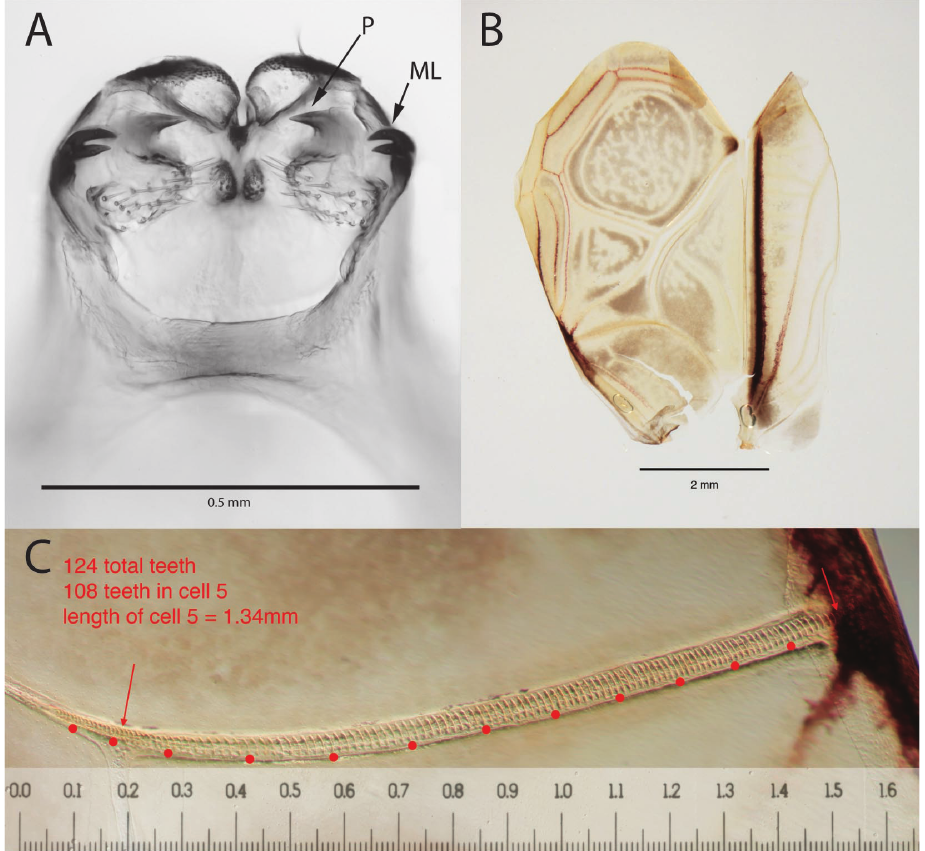
Fig. 2. A. Paratype male genitalia, oblique posterodorsal view, P = paramere, ML = median lophus; B. Paratype male excised left tegmen (recording numbers 140811_01 and 140723_15), posterior edge of tegmen at top of image; C. Paratype male, stridulatory file, same male imaged in